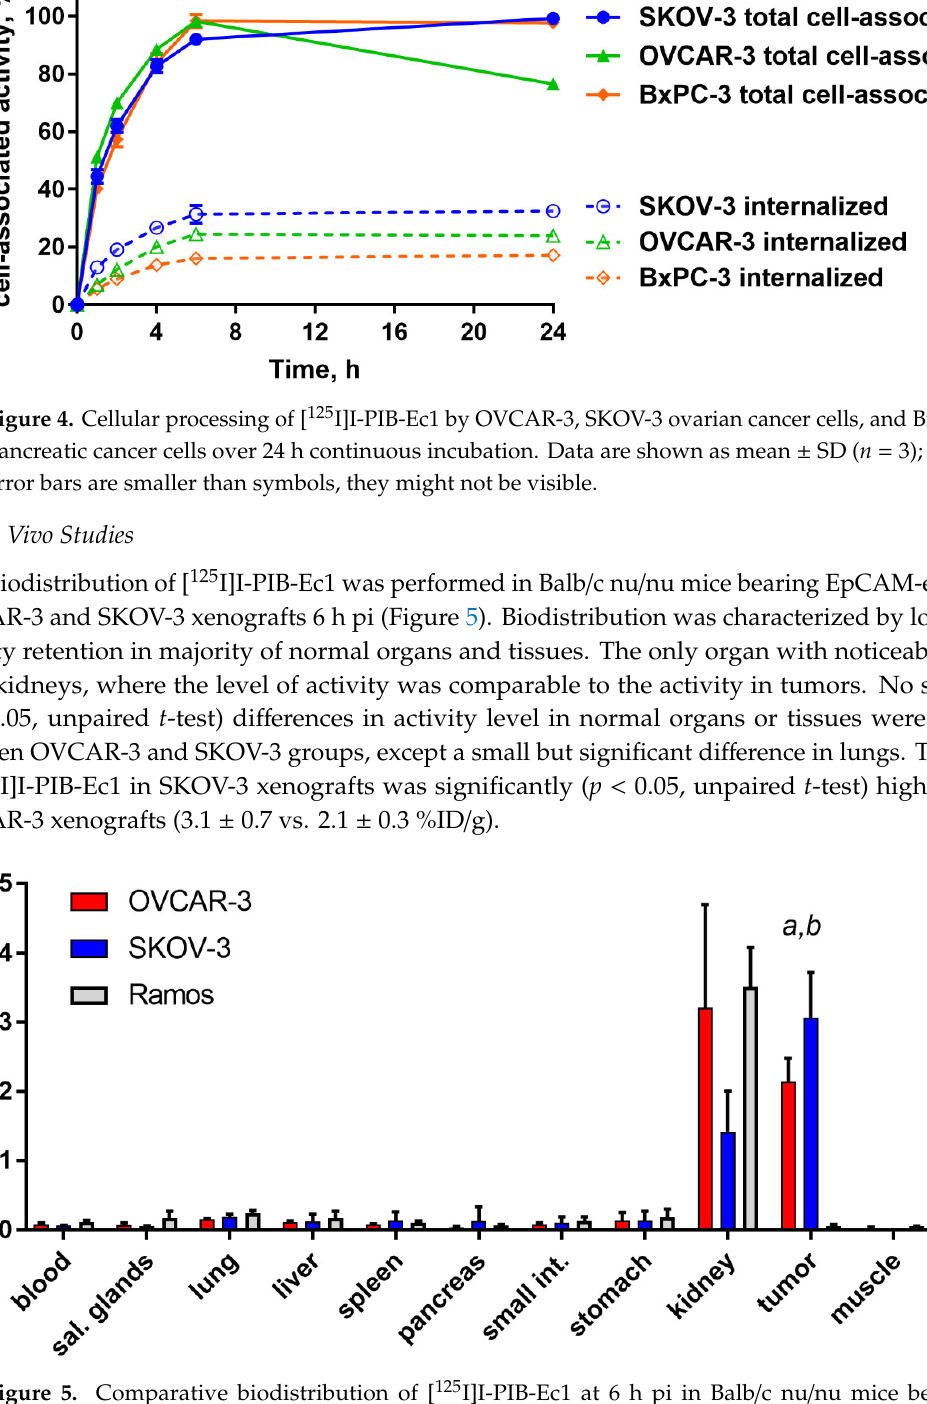
Figure 5. Comparative biodistribution of [ 125 I]I-PIB-Ec1 at 6 h pi in Balb / c nu / nu mice bearing EpCAM-expressing OVCAR-3 and SKOV-3 xenografts and EpCAM-negative Ramos xenografts. Data are presented as the mean ± SD from three to six mice. Letters indicate significant differences ( p < 0.05, one-way ANOVA with Bonferroni’s multiple comparisons test) between: a tumor uptake in SKOV-3 and Ramos xenografts; b tumor uptake in OVCAR-3 and Ramos xenografts. The activity uptake in EpCAM-negative Ramos (Figure 5) xenografts was significantly ( p < 0.05, one-way ANOVA with Bonferroni’s multiple comparisons test) lower compared to the uptake in EpCAM-expressing SKOV-3 or OVCAR-3 xenografts.